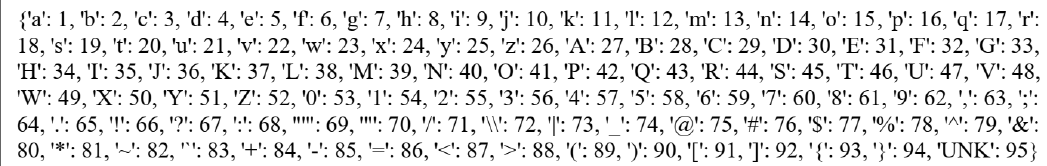
Figure 6. Character vocabulary index representation